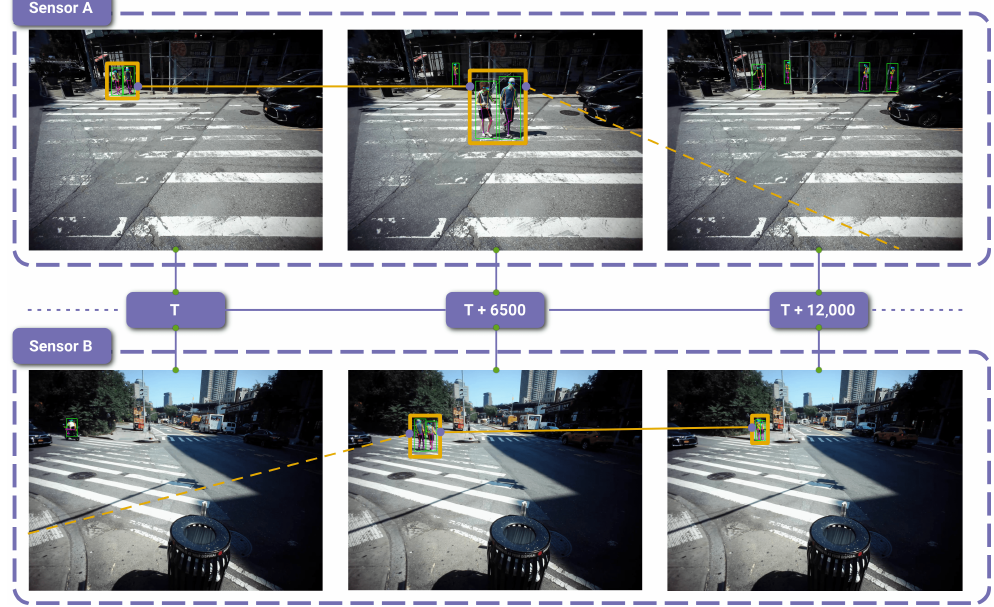
Figure 14. Two camera views from the session 2 recording at DUMBO. Camera A points northwest and Camera B points southwest. At the time T pedestrians (surrounded by an orange box) are visible in camera A but not in camera B. At the time T + 6500, as the pedestrians cross the street, they are observable by both cameras. By T + 12,000, the pedestrians are no longer observable in camera A but are still visible in Camera B as they continue to walk down the sidewalk. Time T represents the global timestamp at the moment the pedestrians begin crossing the street. By extension, T + 12,000 is the time 10 s later because the global timestamps are updated at a rate of 1200 Hz. This figure also highlights the advantage of high-resolution video. With objects at a farther distance from the camera, it becomes more challenging to detect them and estimate their poses. Higher resolutions help mitigate the information loss associated with more distant objects occupying a smaller portion of an